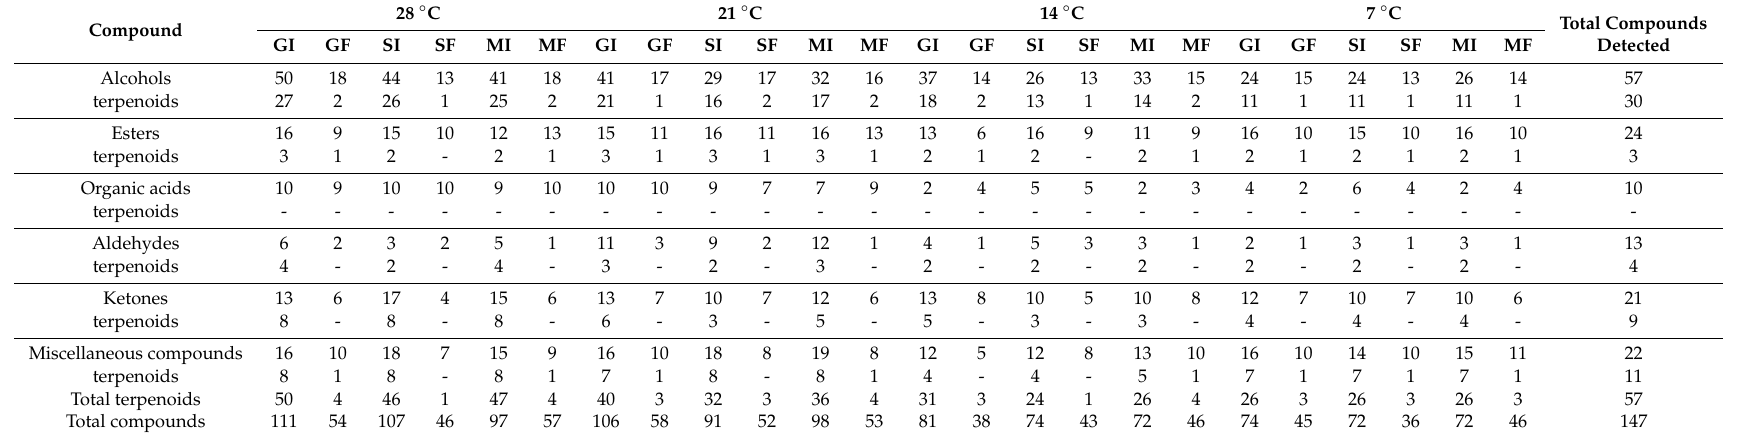
Table 3. Volatile compounds detected by solid phase microextraction / gas chromatography-mass spectrometry (SPME / GC-MS) analysis in fermentation batches of synthetic mediums by free or immobilized S. cerevisiae AXAZ-1 cells on P. terebinthus resin at di ff erent